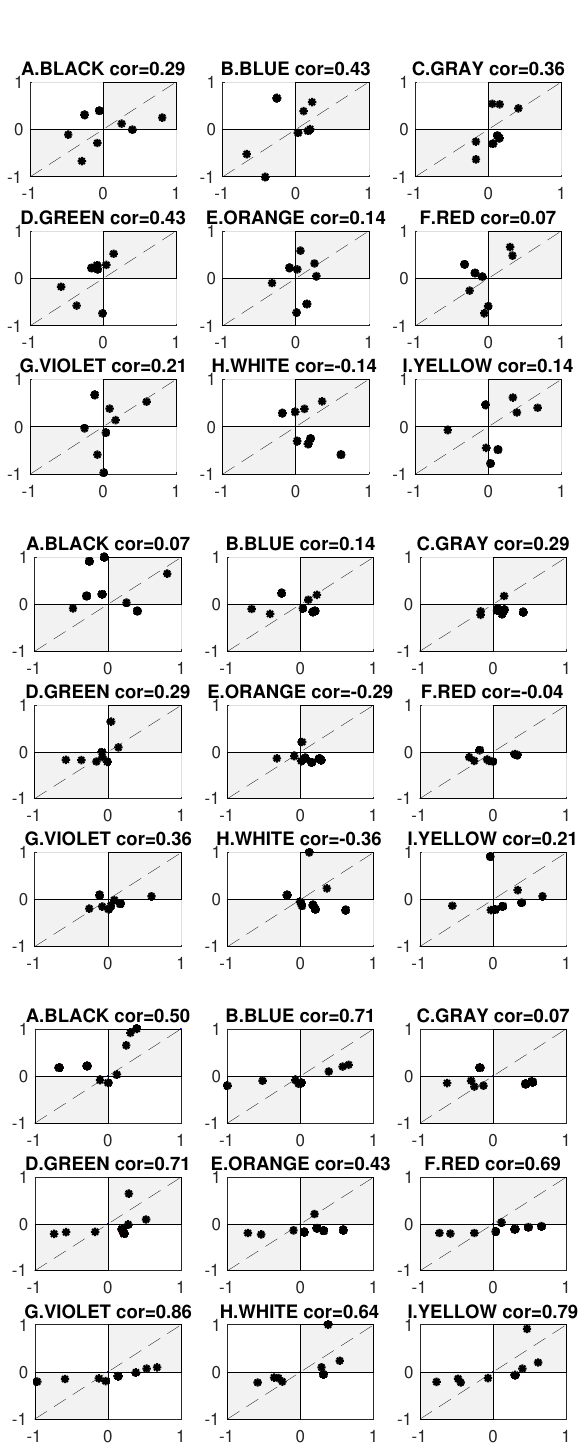
Figure 8. Kendall correlation between ( Top ) the subjective data received from the experiment in the form of user preferences and the objective data represented by time to the first fixation recorded by the eye-tracker; ( Middle ) the objective data and WCAG contrast; ( Bottom ) the subjective data received from the experiment in the form of user preferences and WCAG